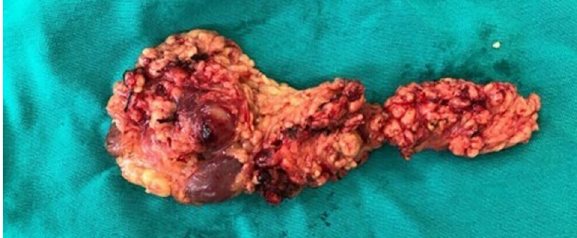
Figure 3. Surgically removed left axillary lymph